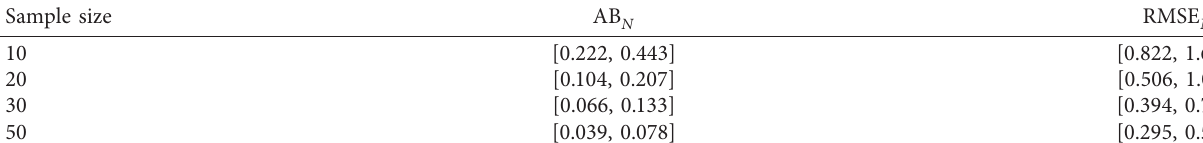
Table 2: Performance of NML estimate of the NED for simulated neutrosophic data.